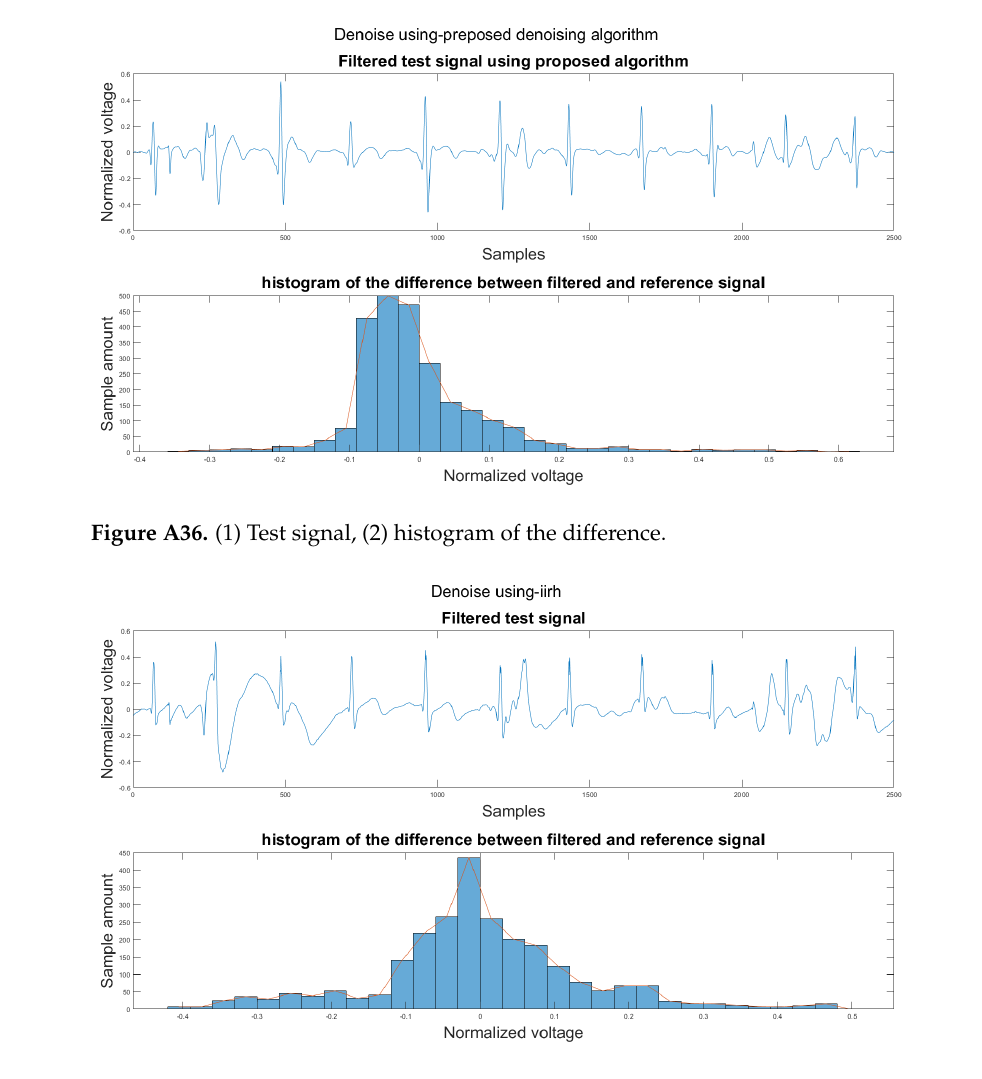
Figure A37. (1) Test signal, (2) histogram of the difference.